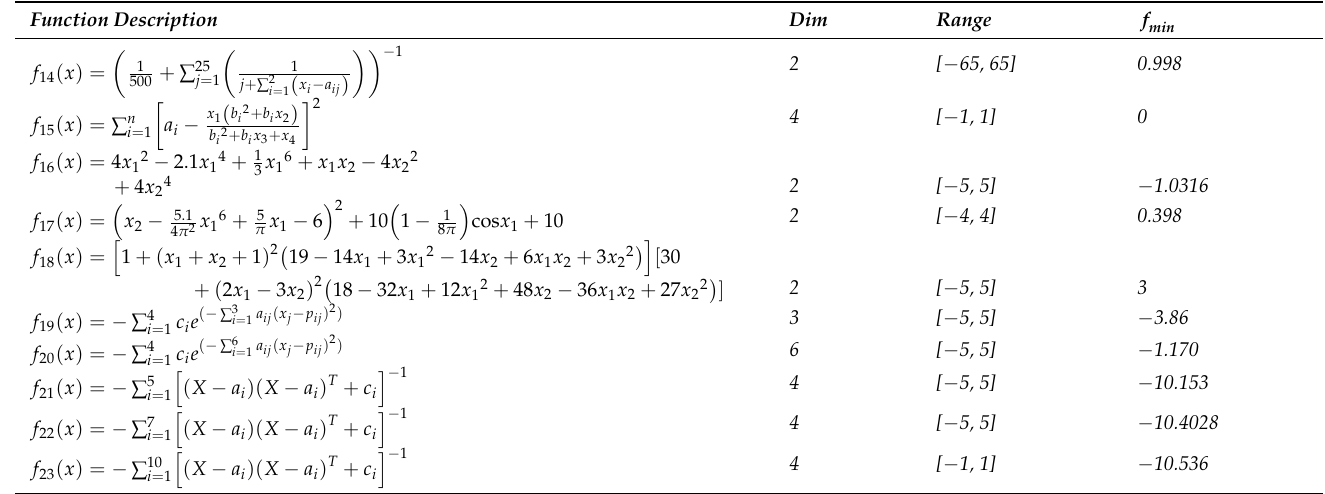
Table A3. Utilized Fixed Dimension Test